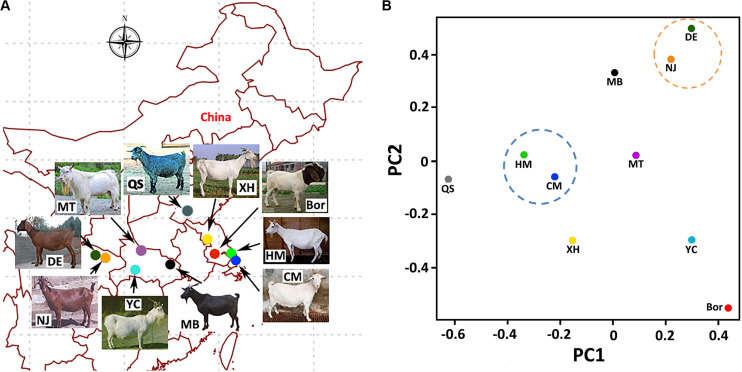
Sampling information and principal component analysis (PCA) of the 10 breeds. (A) Goat breeds and sampling locations. (B) Plot of the first two principal components (PC1 and PC2) of the 10 breeds on the basis of the detected single-nucleotide polymorphisms (SNPs).